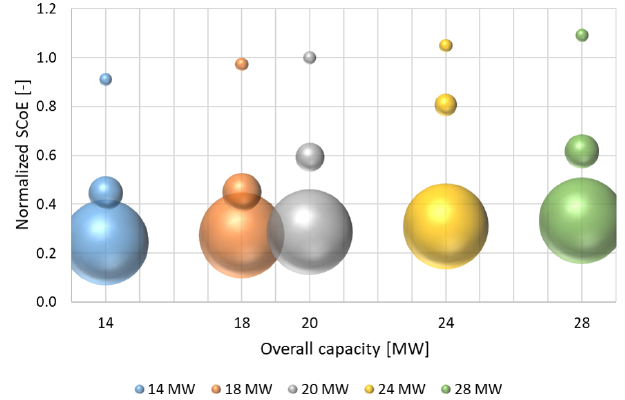
Figure 8. SD-MRS, MD-MRS and SR results for normalized